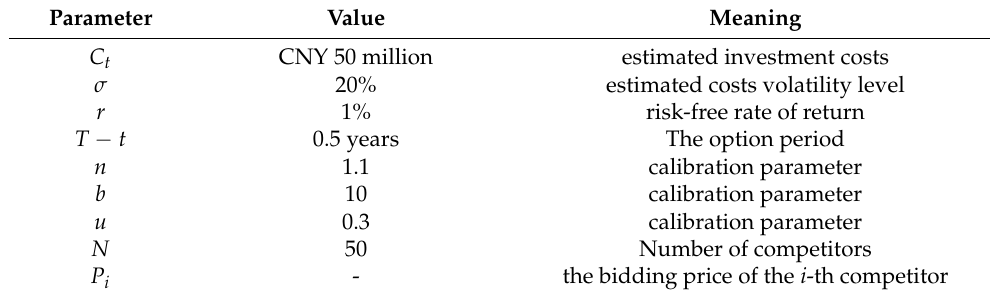
Table 1. The Value and meaning of parameters.